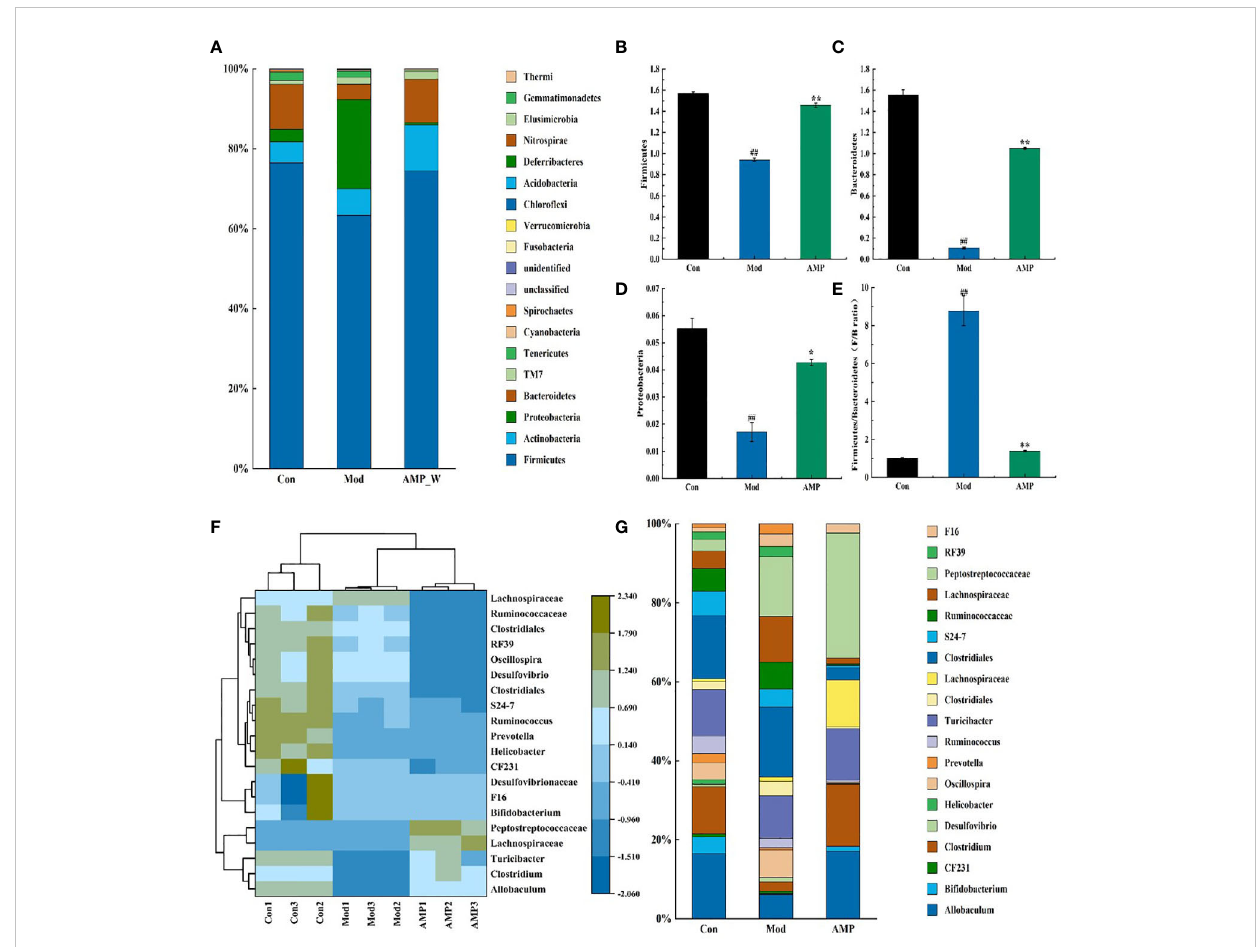
FIGURE 8 Effect of AM-ae on the relative abundance of intestinal microbiota in MGH rats (A) . Relative abundance of door level, (B) Firmicutes, (C) Bacteroidetes, (D) Proteobacteres, (E) Firmitutes/Bacteroides, (F) Horizontal relative abundance heat map, (G) Relative abundance at genus